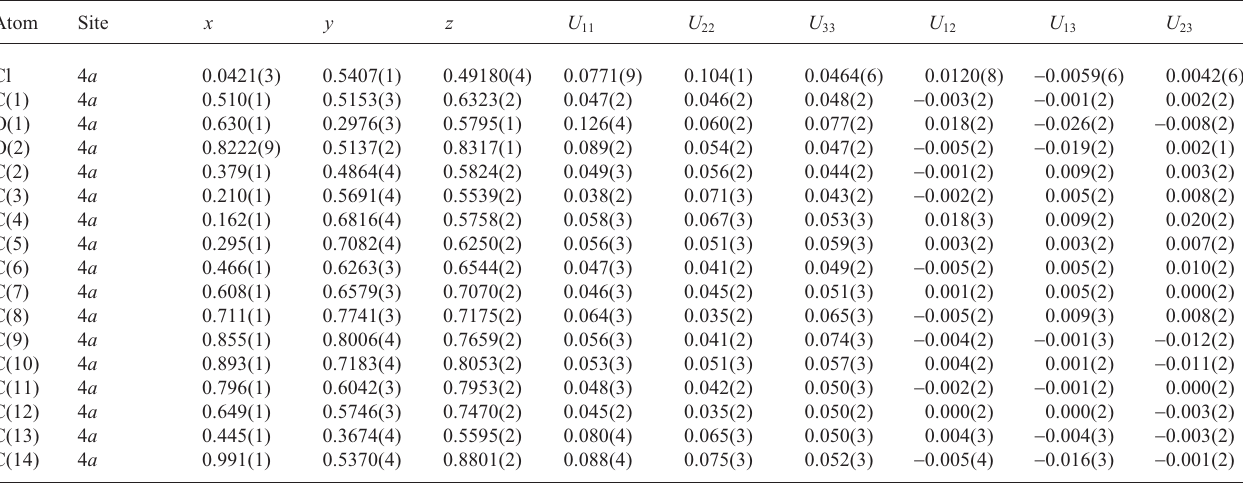
Table 3. Atomic coordinates and displacement parameters (in Å 2 )